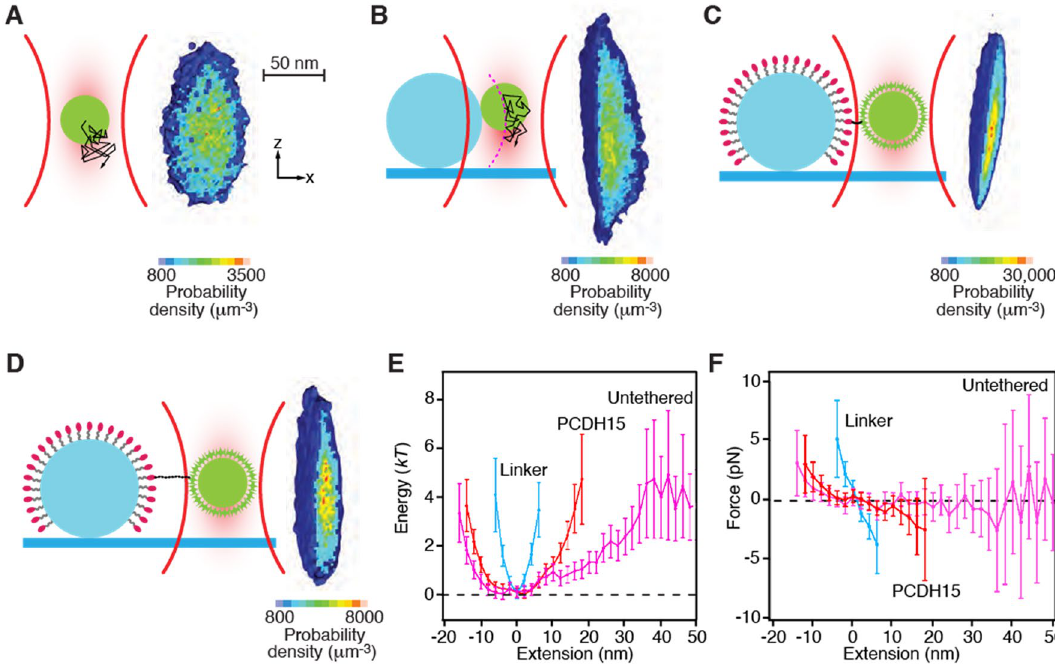
Figure 2. Determination of the pedestal’s position and trap’s strength. ( A ) A schematic diagram (left) portrays the thermal diffusion of the probe in an optical trap. A section through the experimentally measured